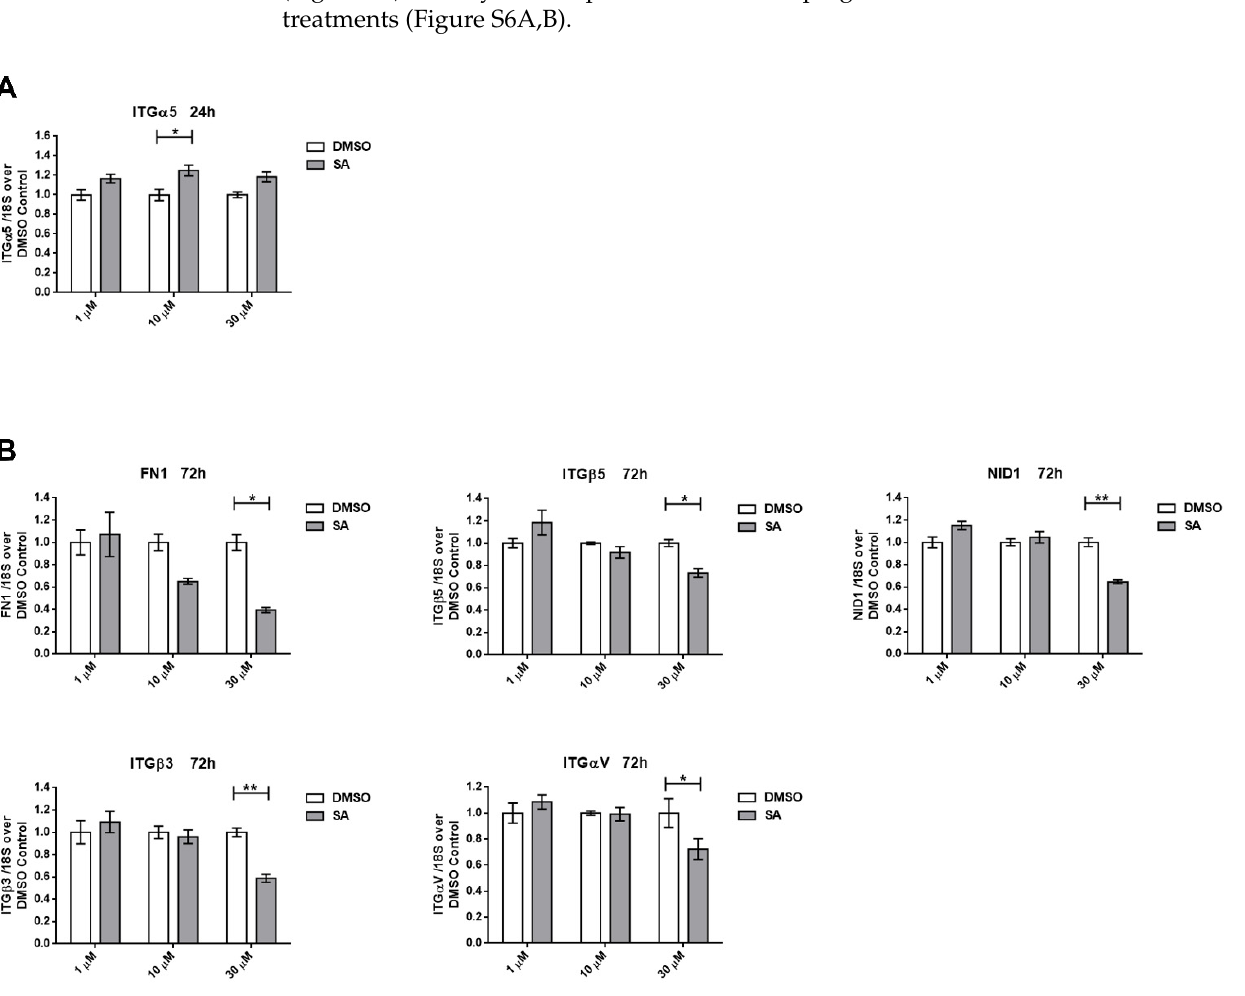
Figure 7. Altered gene expression signature of H1299 cells after SA treatments. A broad panel of genes related to cell adhesion and extracellular matrix composition and remodeling was tested. ( A ) Significant gene expression of control and A549 with SA treated for 24 h. ( B ) Significant gene expression of control and H1299 with SA treated for 72 h. Data represent mean ± SEM gene expression with respect to the 18S-housekeeping gene of three different experiments. * p < 0.05, ** p < 0.01.